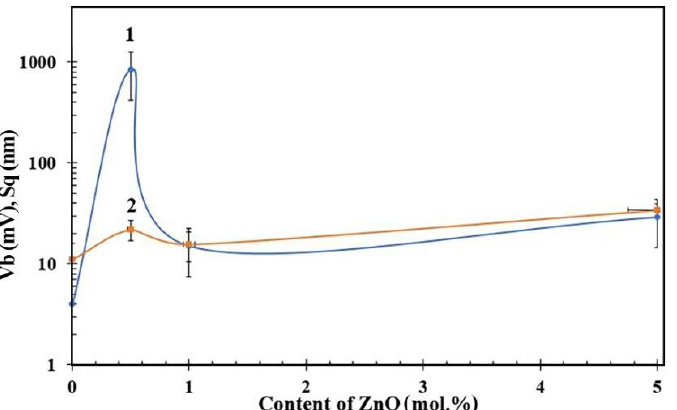
Figure 6. The dependence of the average values of the surface potential V b (curve 1) and the roughness parameters S q (curve 2) on the content of ZnO in the film.